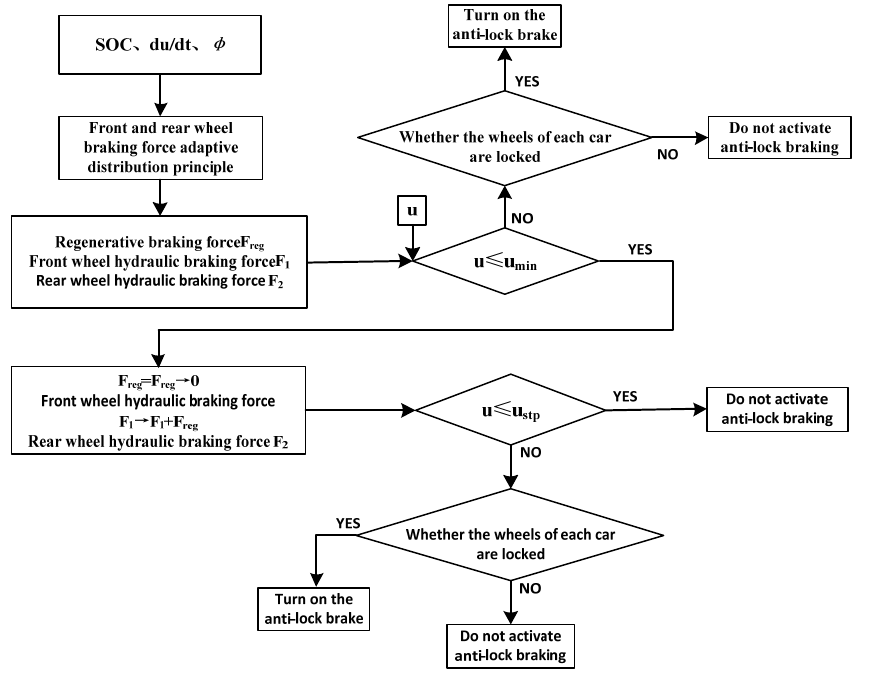
Figure 7. The control strategy of vehicle braking force adaptive distribution.